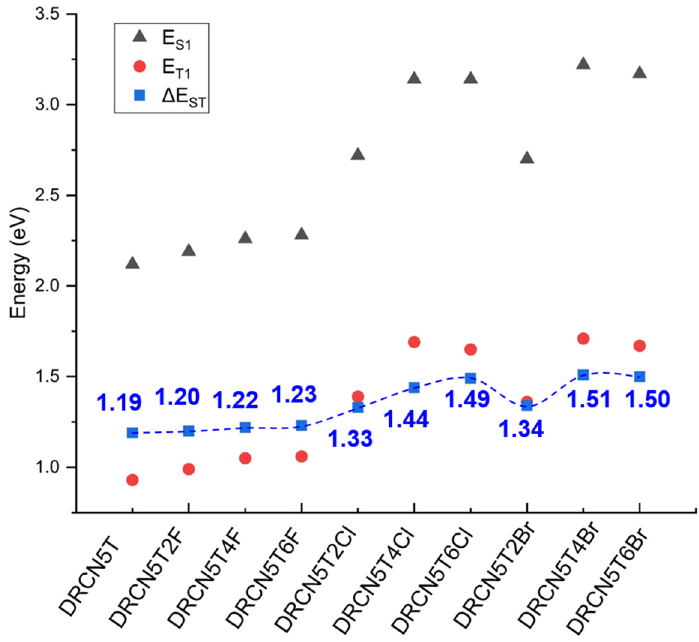
Figure 8. The lowest singlet (E S1 ), triplet excited energy (E T1 ) and singlet–triplet energy gap ( Δ E ST ) of DRCN5T, DRCN5T2F, DRCN5T4F, DRCN5T6F, DRCN5T2Cl, DRCN5T4Cl, DRCN5T6Cl, DRCN5T2Br, DRCN5T4Br, and DRCN5T6Br with CAM-B3LYP/6 − 31+G(d) in film ( ε = 3.0).